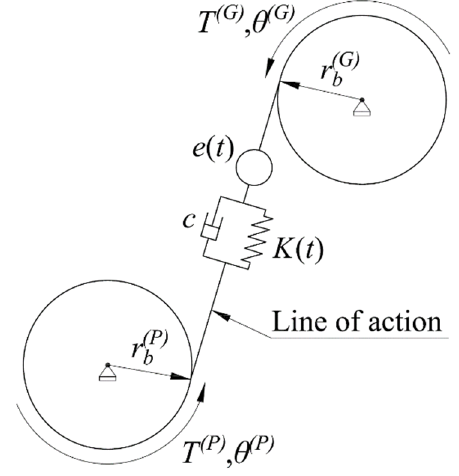
Figure 10. Dynamic model of spur gear pair.